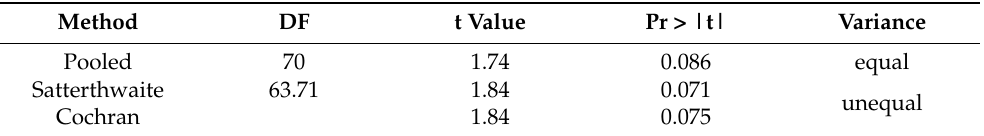
Table 13. Two-sample t-test for the speed di ff erence (V85 − RSL) between the high and low accident rate groups.